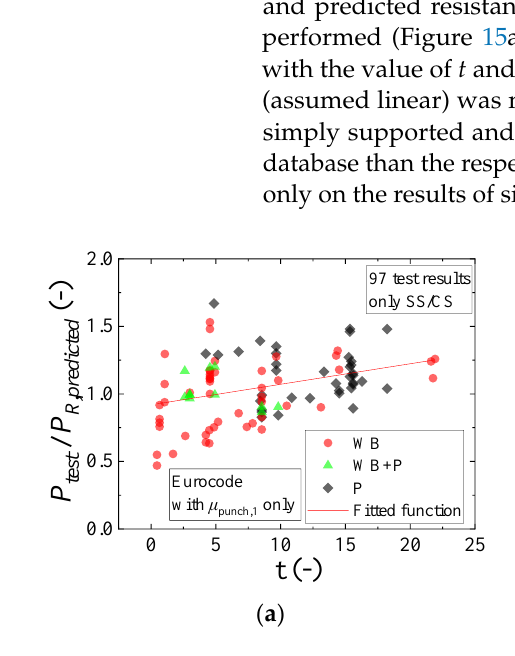
Figure 15. Comparison between tested and predicted resistances using the punching capacity expressions from Eurocode according to the parameter t (related to the slab width) for the dataset of simply supported and continuous slabs (97 tests results): ( a ) using only the factor μ punch,1 and ( b ) using both factors μ punch,1 and μ punch,2 .